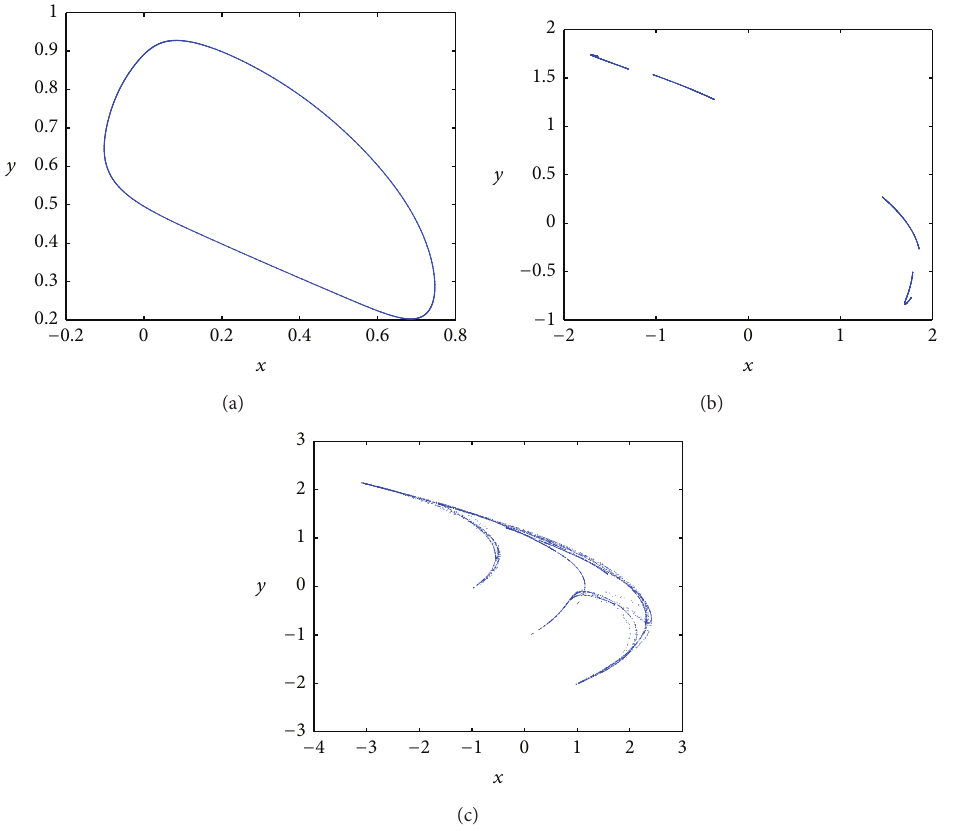
Figure 11: Phase portraits corresponding to Figure 10: (a) 𝑑 = −0.9 , (b) 𝑑 = 0.28 , and (c) 𝑑 = 0.4 .